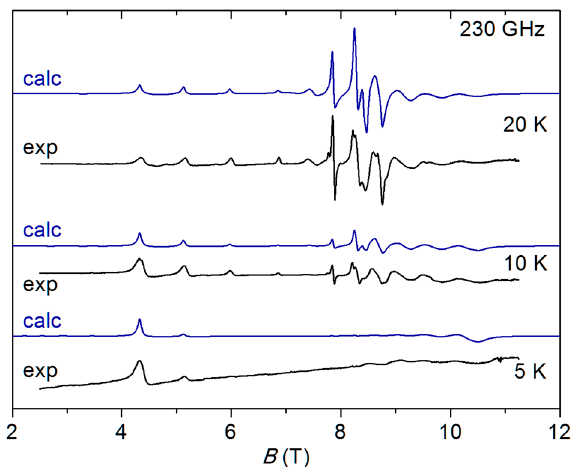
Figure 5. Experimental (exp) and calculated (calc) HF-EPR spectra of 1 at 230 GHz and different Experimental (exp) and calculated (calc) HF-EPR spectra of 1 at 230 GHz and temperatures. di ff erent